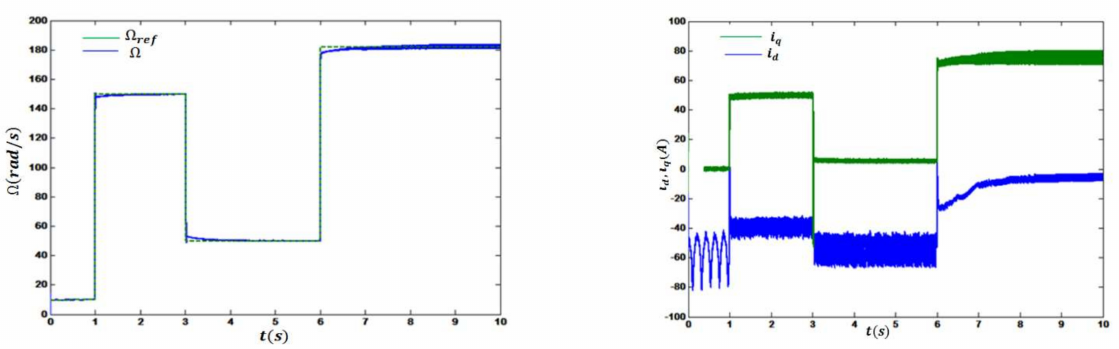
Figure 11. PMSM performance for low, middle and high reference speed for the maximum power operating point MPOP 1 , and for T = 25 ◦ C.